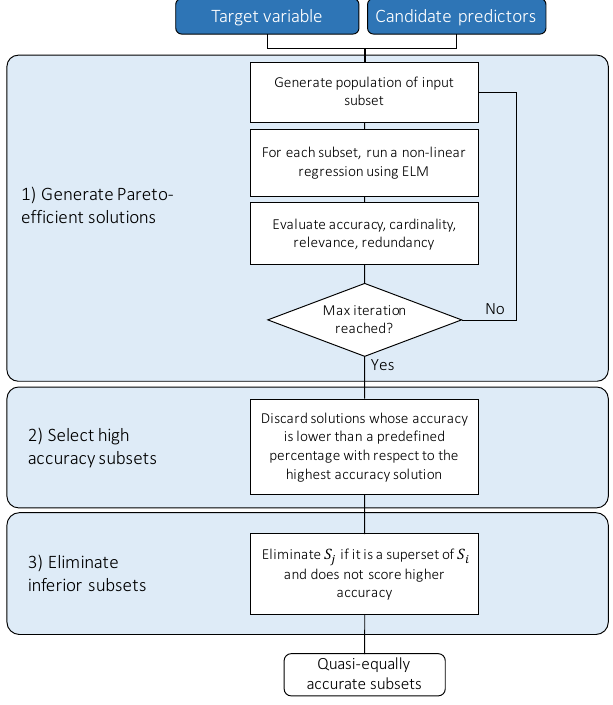
Figure 3. The W-QEISS flowchart. Step 1: generate Pareto-efficient solutions with respect to the four objectives of relevance, redun- dancy, cardinality, and accuracy; step 2: select high accuracy sub- sets; step 3: eliminate inferior